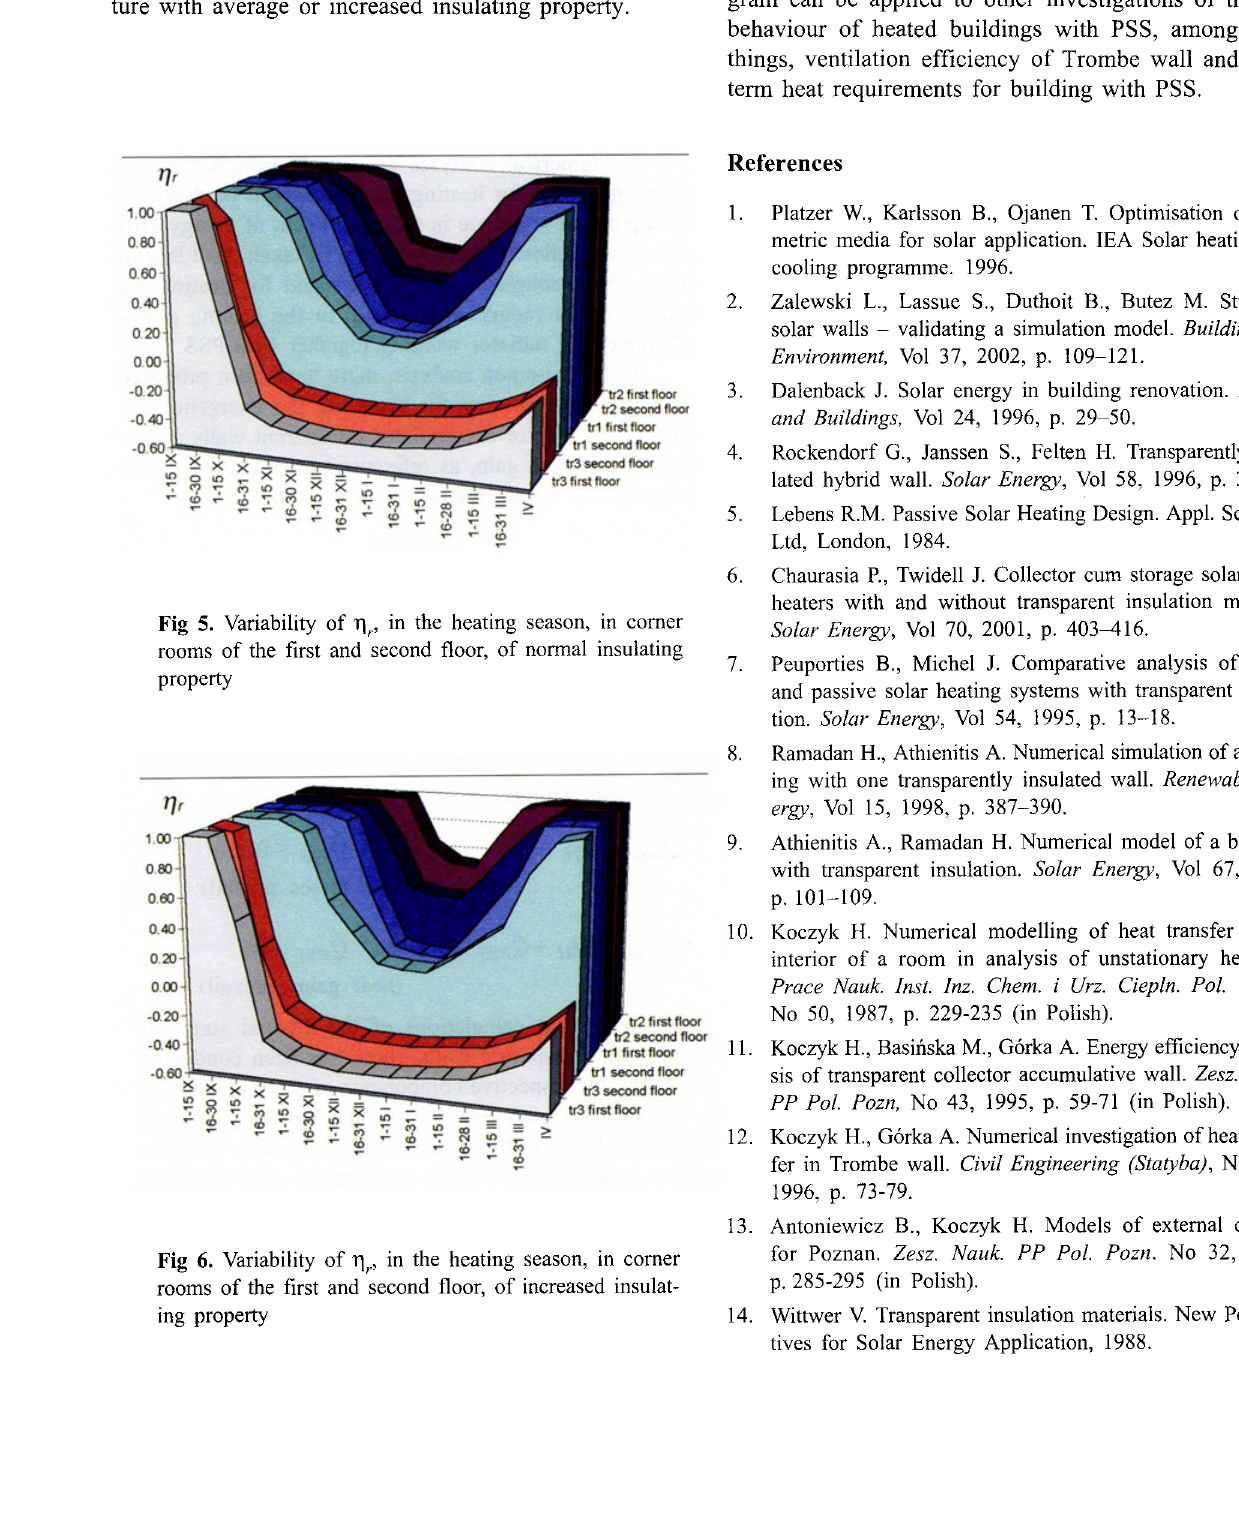
Fig 6. Variability of Tlr' in the heating season, in comer rooms of the first and second floor, of increased insulat ing